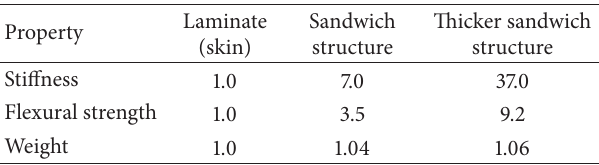
Table 1: Relative characteristics of sandwich structures in relation to solid material [9] (see Figure